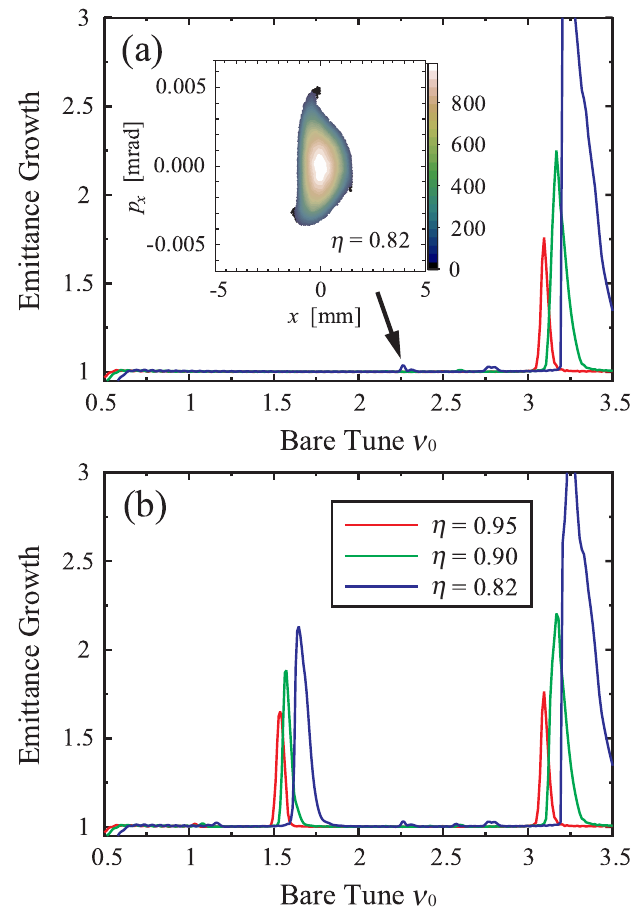
FIG. 12. (Color) PIC simulation results showing emittance growth after 0.1 msec as a function of the bare tune (cid:4) 0 . The initial distribution is waterbag form rms matched to the rf focusing force. Three different tune depressions (cid:6) are shown to confirm the stop band shifts. The upper and lower figures correspond to the following cases: (a) N sp ¼ 12 (no perturbation wave applied), and (b) N sp ¼ 3 (the lattice-induced wave added, whose amplitude is 0.5% of the primary focusing-wave ampli- tude). In (a), the transverse phase-space projection of the plasma observed after 100 rf periods is shown for (cid:4) 0 (cid:3) 2 : 25